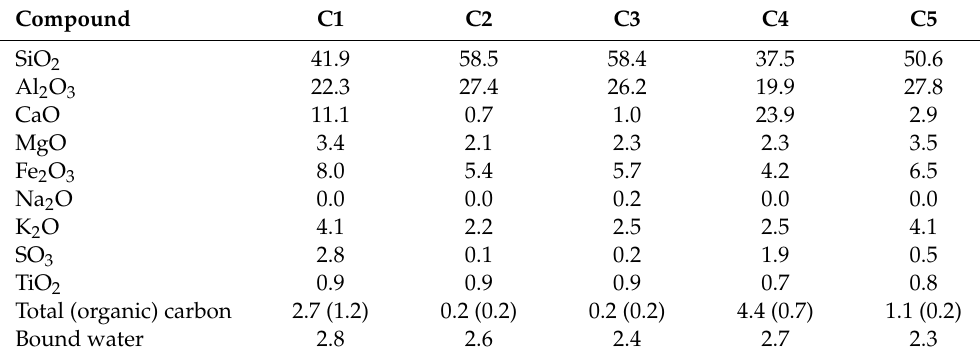
Table 2. Chemical composition of the clays (percent by